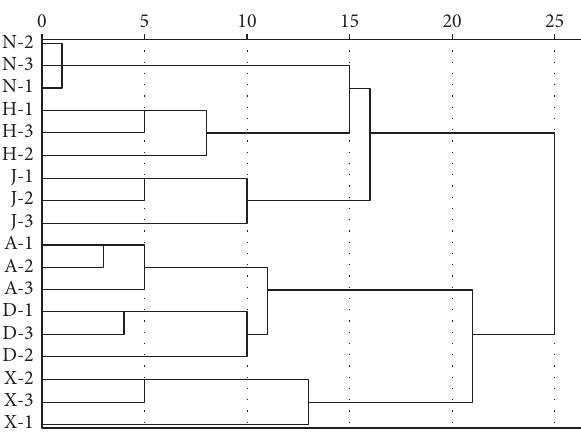
Figure 4: Systematic clustering of element content. A- Anhui Province, X- Guangxi Province, D- Guangdong Province, J- Jilin Province, H- Heilongjiang Province, and N- Inner